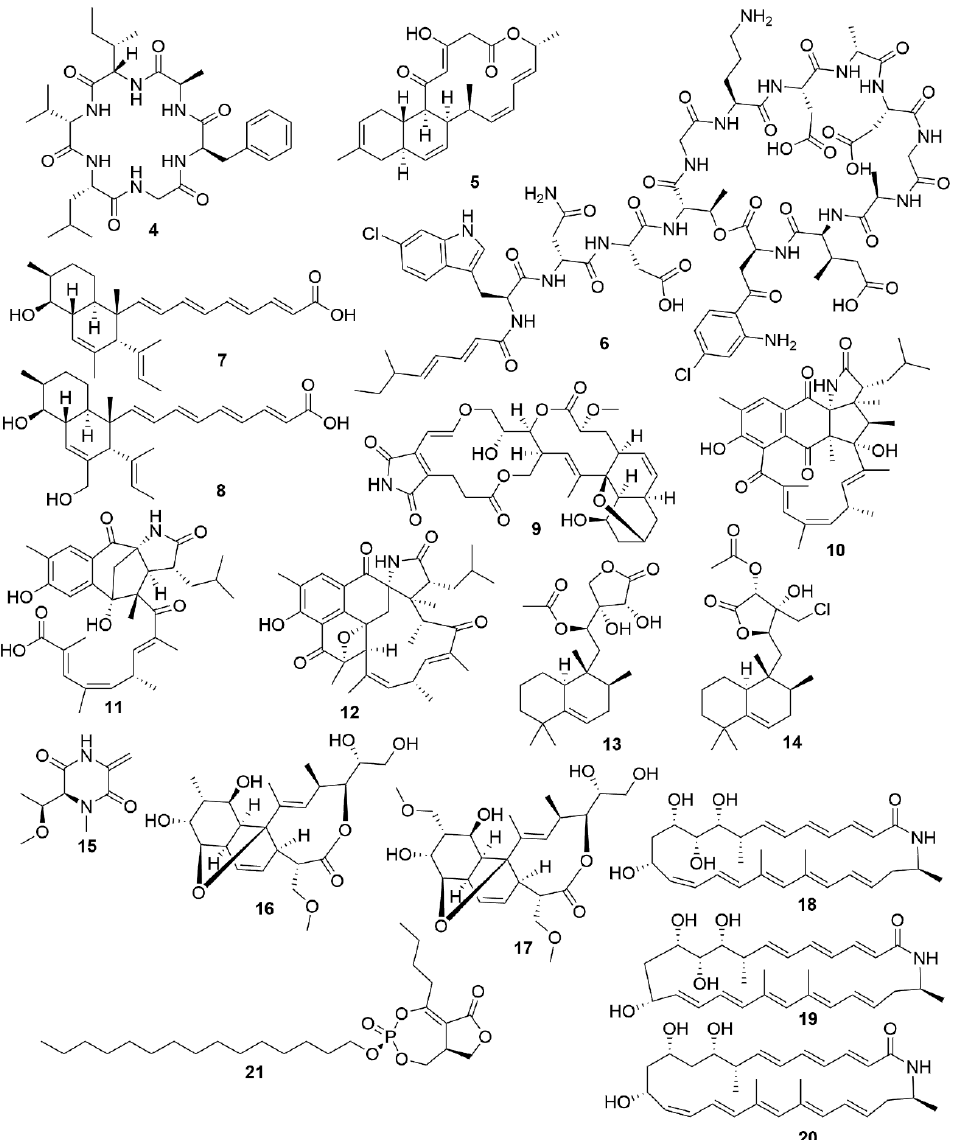
Figure 2. Examples of recently isolated antimicrobial natural products from marine bacteria. Bacicyclin ( 4 ), a cyclic peptide isolated from a Bacillus sp. BC028. Anthramicin B ( 5 ), a polyketide isolated from S. cyaneofuscatus M-169. Taromycin B ( 6 ), a lipopeptide from Saccharomonospora sp. CNQ-490. Janthinopolyenemycin A ( 7 ) and Janthinopolyenemycin B ( 8 ). The janthinopolyenemycins are polyketides isolated from two strains of the genus Janthinobacterium . Streptoseomycin ( 9 ), a macrolactone isolated from S. seoulensis . Ansalactam B ( 10 ), a pentacyclic polyketide. Ansalactam C ( 11 ), an open polyketide unlike ansalactam B. Ansalactam D ( 12 ), a hexacyclic polyketide. Ansalactams B, C and D were isolated from Streptomyces sp. CNH189. Micromonohalimane A ( 13 ). Micromonohalimane B ( 14 ). Micromonohalimanes A and B are terpenes isolated from Micromonospora sp. WMMC-218. Xestostreptin ( 15 ), a diketopiperazine isolated from Streptomyces sp. S.4. Branimycin B ( 16 ) and Branimycin C ( 17 ) C are macrolides isolated from the deep-sea bacterium P. carboxydivorans M-227. Lobosamide A ( 18 ), Lobosamide B ( 19 ) and Lobosamide C ( 20 ) are macrolactams isolated from Micromonospora sp. RL09-050-HVF-A. Salinipostin A ( 21 ), a bicyclic phosphotriester isolated from Salinispora sp.